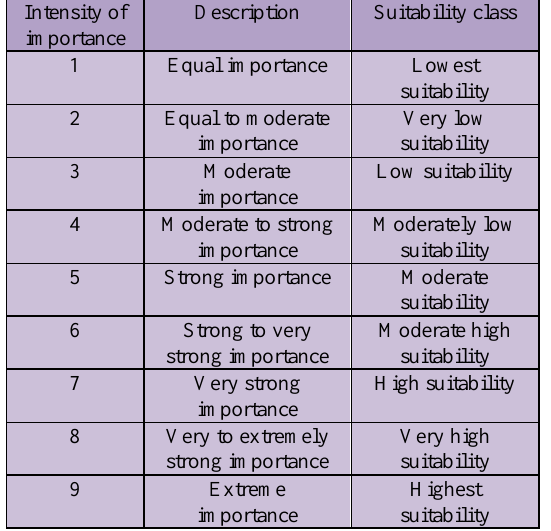
Then, make the weight normalization and calculate the consistency ratio (CR). The formula as shown in equation (1) and (2).